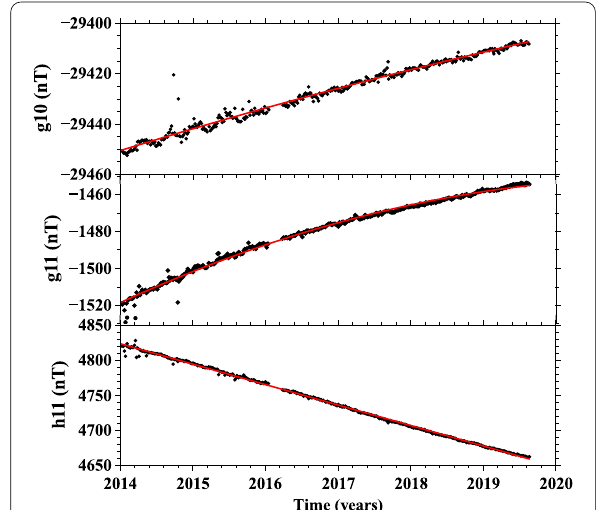
Fig. 1 Variations of spherical harmonic coefficients g10, g11, h11 over the period 2014–2020. Red lines show parabolic fit to